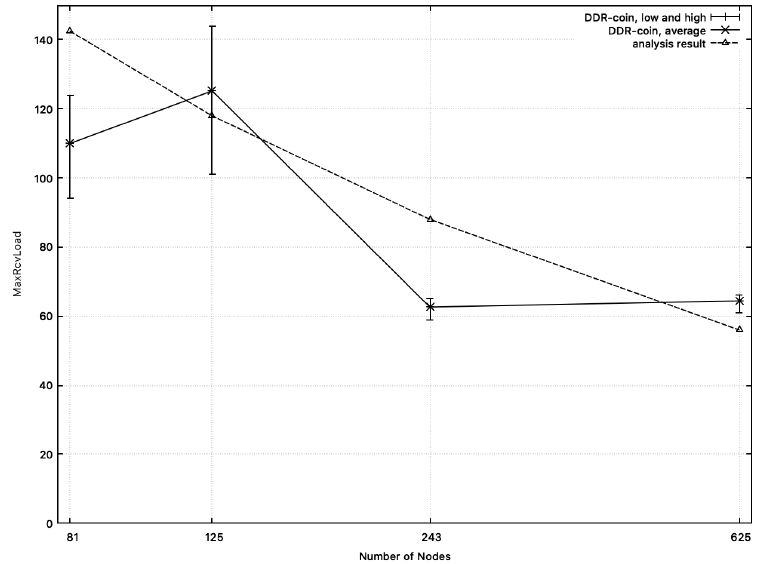
Figure 12. MaxRcvLoad: the measured numbers from simulations and the analysis results from Section 3 when k = 3 or 5, w = 10,000, and n = 3 4 ,3 5 ,5 3 ,5 4 . The solid line represents MaxRcvLoad measured from simulation. The dotted line (analysis results) represents the function: 130 · log